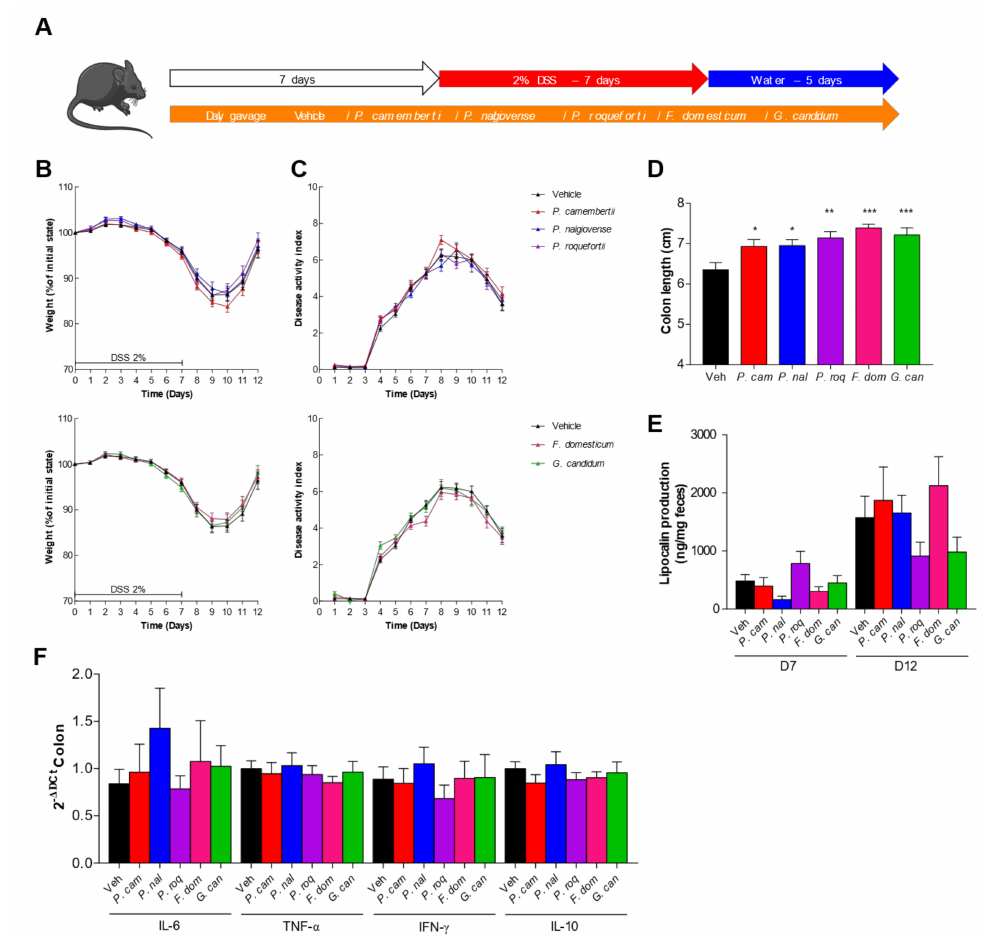
Figure 4. Dextran sodium sulfate (DSS)-induced colitis is not influenced by fungal spores’ coloniza- tion. ( A – F ) Mice received vehicle (Veh, PBS), Penicillium camemberti ( P. cam ), P. nalgiovense ( P. nal ), P. roqueforti ( P. roq ), Fusarium domesticum ( F. dom ), or Geotrichum candidum ( G. can ) for 7 days and then dextran sulfate sodium (DSS) for 7 days. Vehicle n = 23, P. cam n = 25, P. nal n = 22, P. roq n = 24, F. dom n = 26, G. can n = 24. A. Experimental design for the administration of DSS. B. Weight of DSS-exposed mice. C. Disease activity index (DAI) of DSS-exposed mice. D. Length of the colons of mice treated with DSS. E. Intestinal inflammation, expressed as the lipocalin levels in feces at Day 7 and Day 12. F. Intestinal cytokines IL-6, TNF- α , IFN- γ , and IL-10 in the colon (qPCR). For statistical comparisons, (*) indicates versus vehicle. * p < 0.05, ** p < 0.01, *** p <